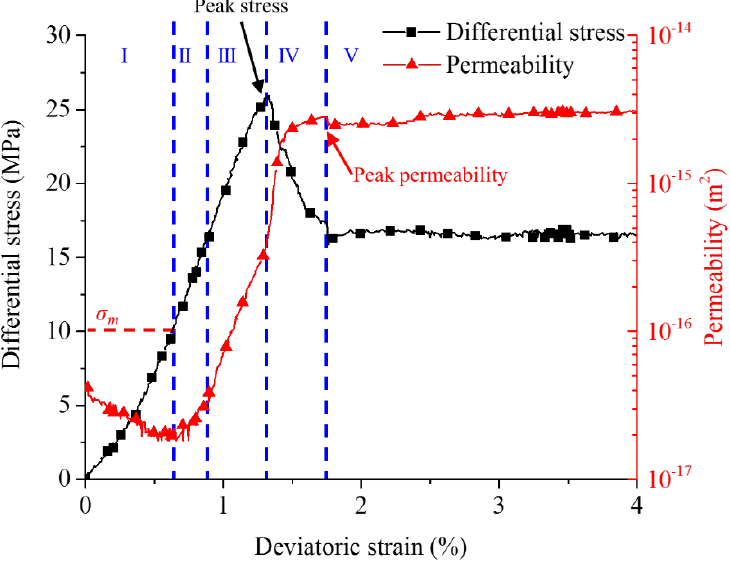
Figure 13. Differential stress (axial stress minus circumferential stress) and permeability evolution versus axial strain for sample C1 (with a confining pressure of 2.5 MPa).